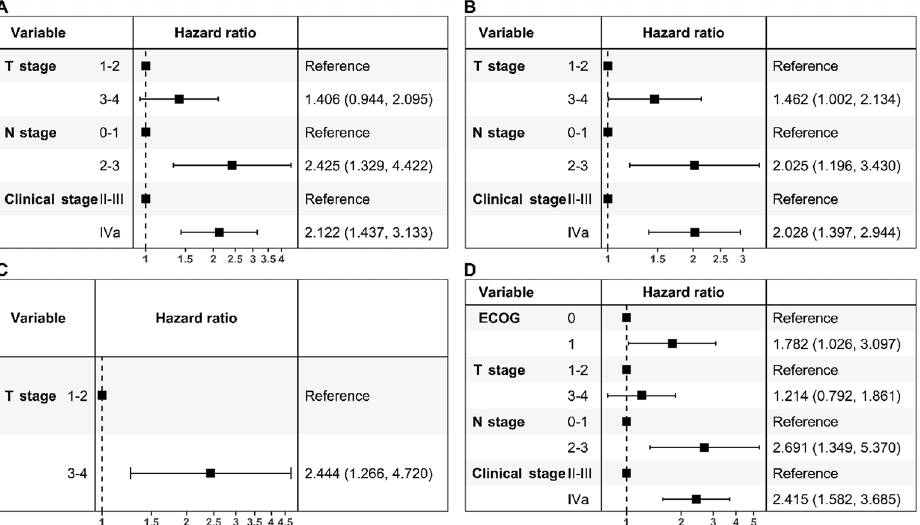
Figure 2. Forest plot based on multivariate analysis-based adjusted hazard ratios (HRs) from Cox regression for overall survival ( A ), progression-free survival ( B ), locoregional relapse-free survival ( C ), and distant metastasis- free survival ( D ) in the entire cohort (n = 538).